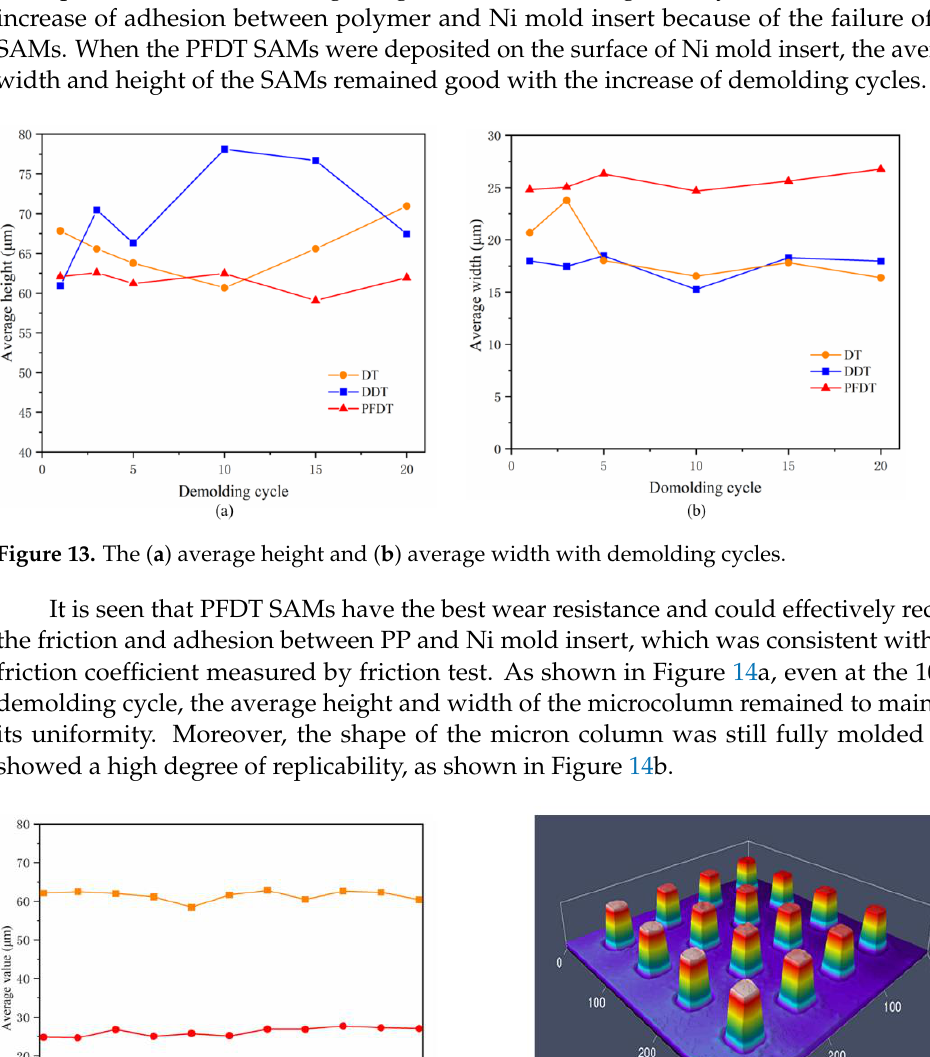
Figure 12. Morphology of local microstructure with demolding cycles: ( a ) DT; ( b ) DDT; ( c ) PFDT .